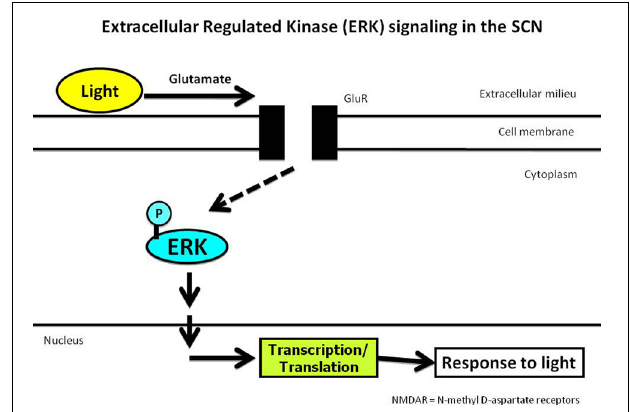
FIGURE 1 | Light-induced ERK phosphorylation is required for producing an appropriate response to the light